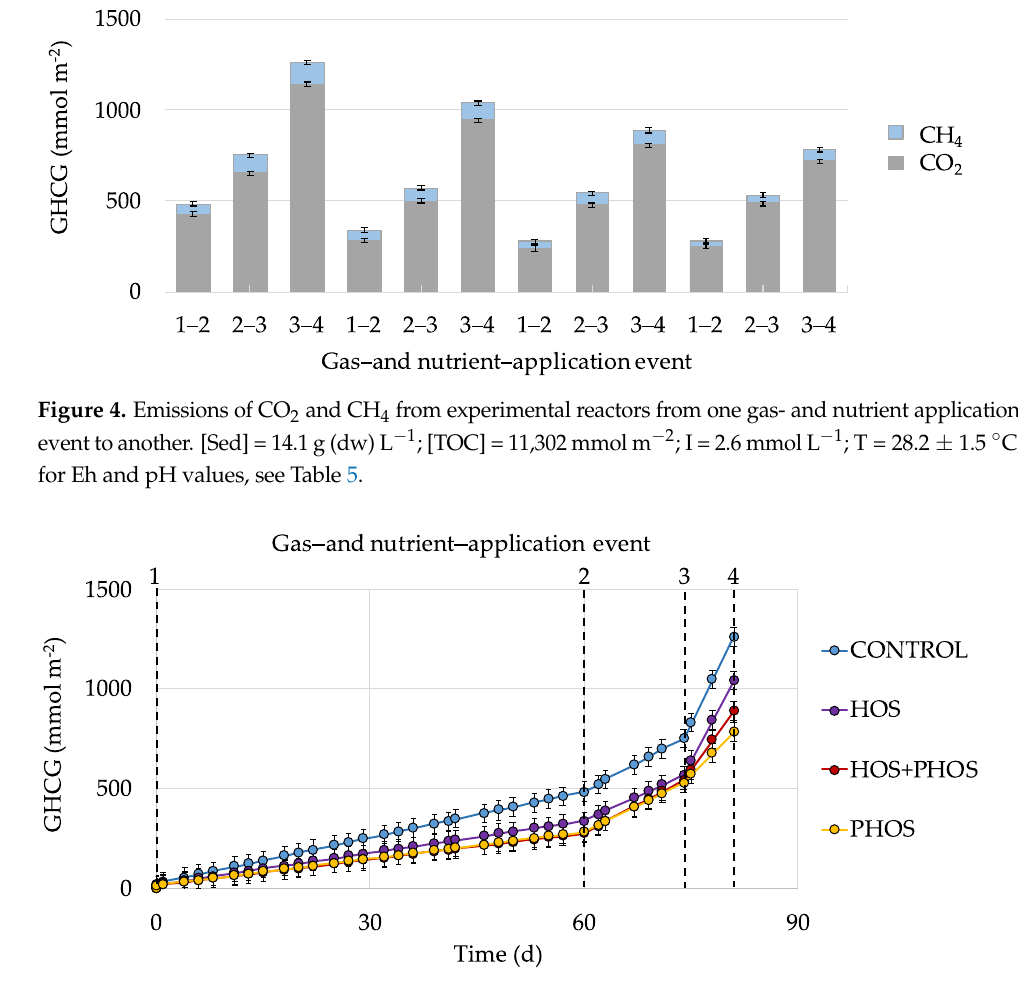
Figure 5. Time-dependent emissions of GHCG in experimental reactors. [Sed] = 14.1 g (dw) L − 1 ; [TOC] = 11,302 mmol m − 2 ; I = 2.6 mmol L − 1 ; T = 28.2 ± 1.5 °C; for Eh and pH values, see Table 5.